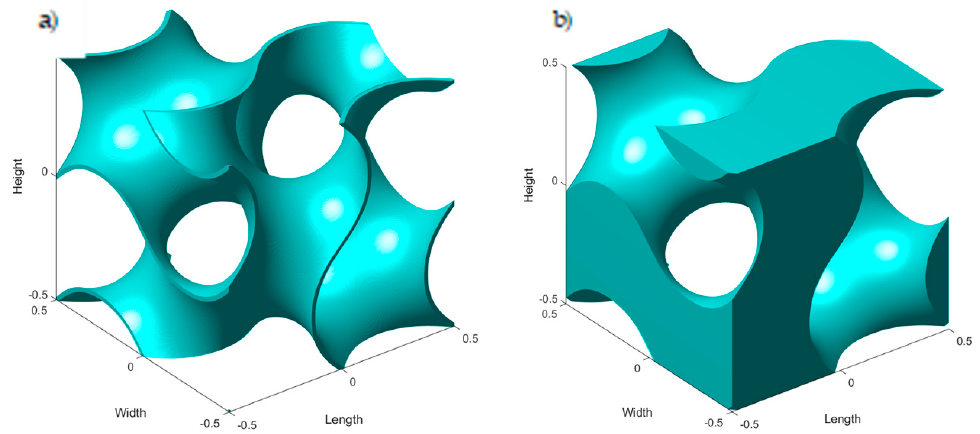
Figure 4. Gyroid structure types: ( a ) sheet network, ( b ) solid network. Formulas (1)–(7) contained in Table 1 express the mathematical notation of the minimal area, which, with minor modifications, can be used to describe the TPMS. For